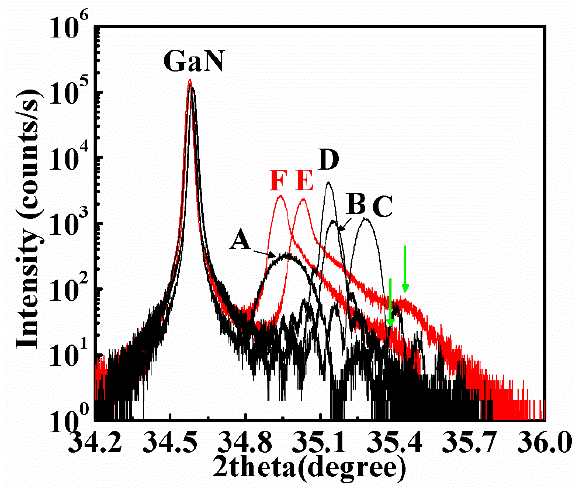
Figure 1. HRXRD (0002) 2 θ / ω scans of the six samples. Table 1. Some of the structural parameters for the six samples in this study, including the thickness of InAlN ( d ), the FWHMs of (0002), ω -scanrocking curves, the In contents and template type.